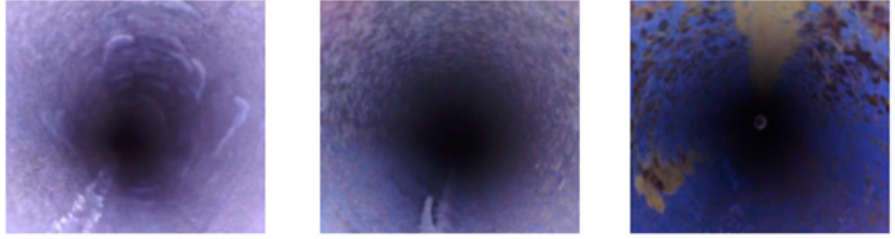
Figure 4. Partial image acquisition result map.